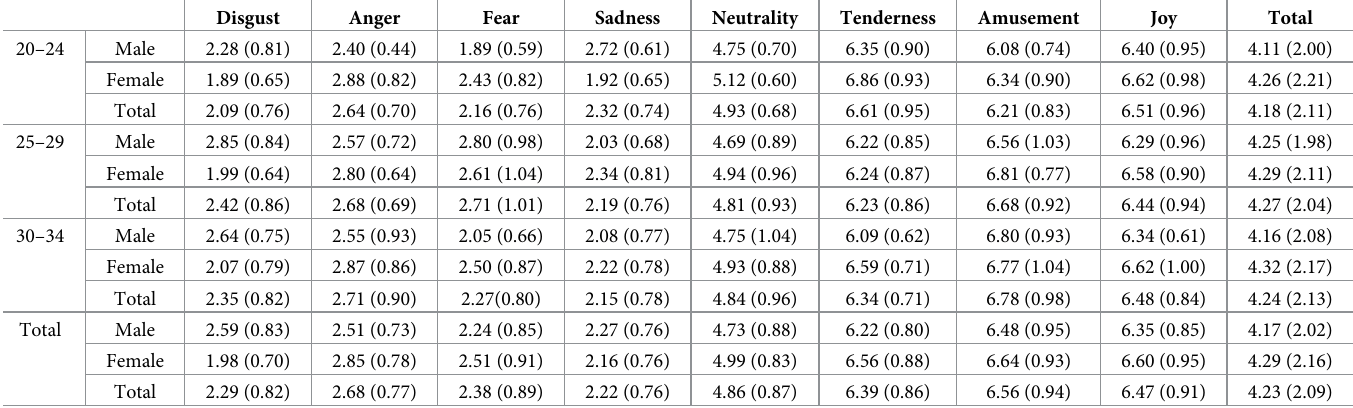
Table 1. The descriptive statistical results on the valence